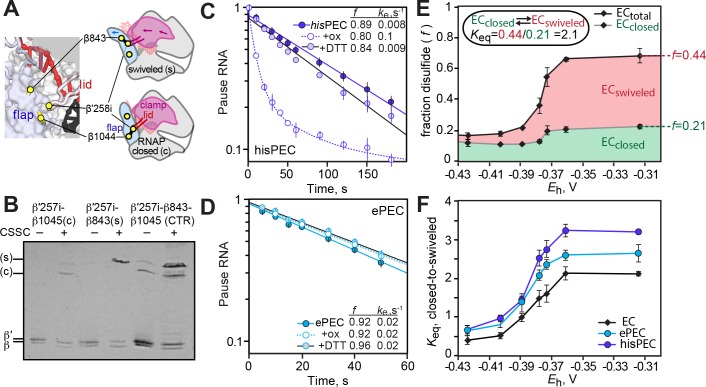
Restriction of clamp movement has less effect on ePEC than on hairpin-stabilized PEC.(A) Location of disulfides used to restrict clamp movement or generate the Cys-triplet reporter (CTR; described in Hein et al., 2014; Kang et al., 2018b). (B) Example β-β′ disulfide mobilities during SDS-PAGE illustrating the identification of the closed (β1044-β′258i, (c) or swiveled (β843-β′258i, (s) disulfides. (C) Effect of the closed clamp crosslink on pausing by the hairpin-stabilized hisPEC (scaffold shown in Figure 6—figure supplement 1A). (D) Effect of the closed clamp crosslink on pausing by the ePEC (scaffold shown in Figure 1—figure supplement 1A). (E) CTR assay on an EC scaffold illustrating the formation of the closed and swiveled crosslinks as a function of redox potential generated by increasing concentrations of cystamine (Figure 6—figure supplement 1F). (F) CTR assay of clamp swiveling in EC, ePEC, and hisPEC (scaffolds shown in Figure 6—figure supplement 1B,C,D, respectively).